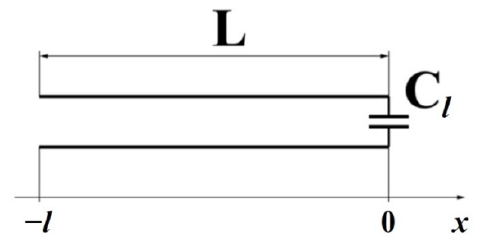
Figure 17. An equivalent scheme of a resonator